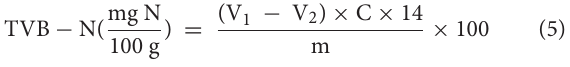
FIGURE 3 | Influence of different freezing treatments on the thawing loss (A) , cooking loss (B) , and WHC (C) of the large yellow croaker. The results are average ± standard deviation ( n =